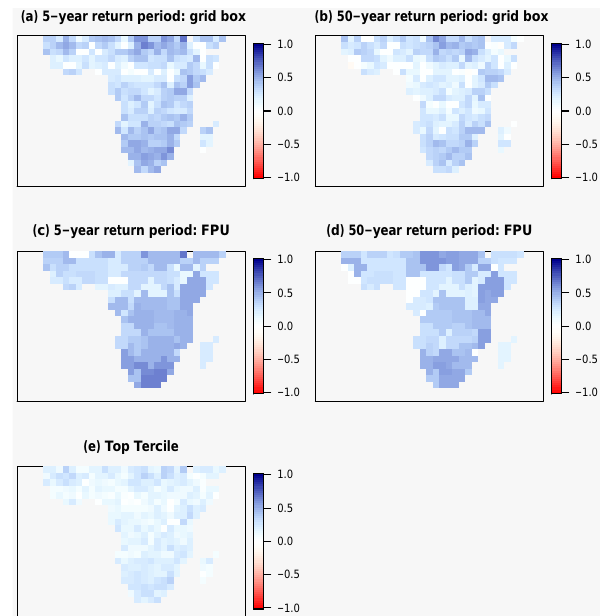
Figure 1. Anomaly rank correlations between seasonal total rainfall and percentage floodiness (Stephens et al., 2015) at the 5-year (a) and 50-year (b) return periods. Anomaly rank correlations between seasonal total rainfall for a 2.5 ◦ gridded food producing unit (FPU) and floodiness for that FPU at the 5-year (c) and 50-year (d) re- turn periods. Correlations are only shown here if more than 95% of all boostrapped replicates agreed on the sign of the result. The increase in probability of floodiness above the 5-year return period conditional on seasonal total rainfall falling in the top tercile (e) , expressed as the difference in probability relative to